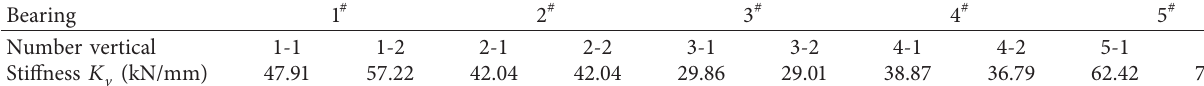
Table 9: Pressure stiffness Kv calculation results.